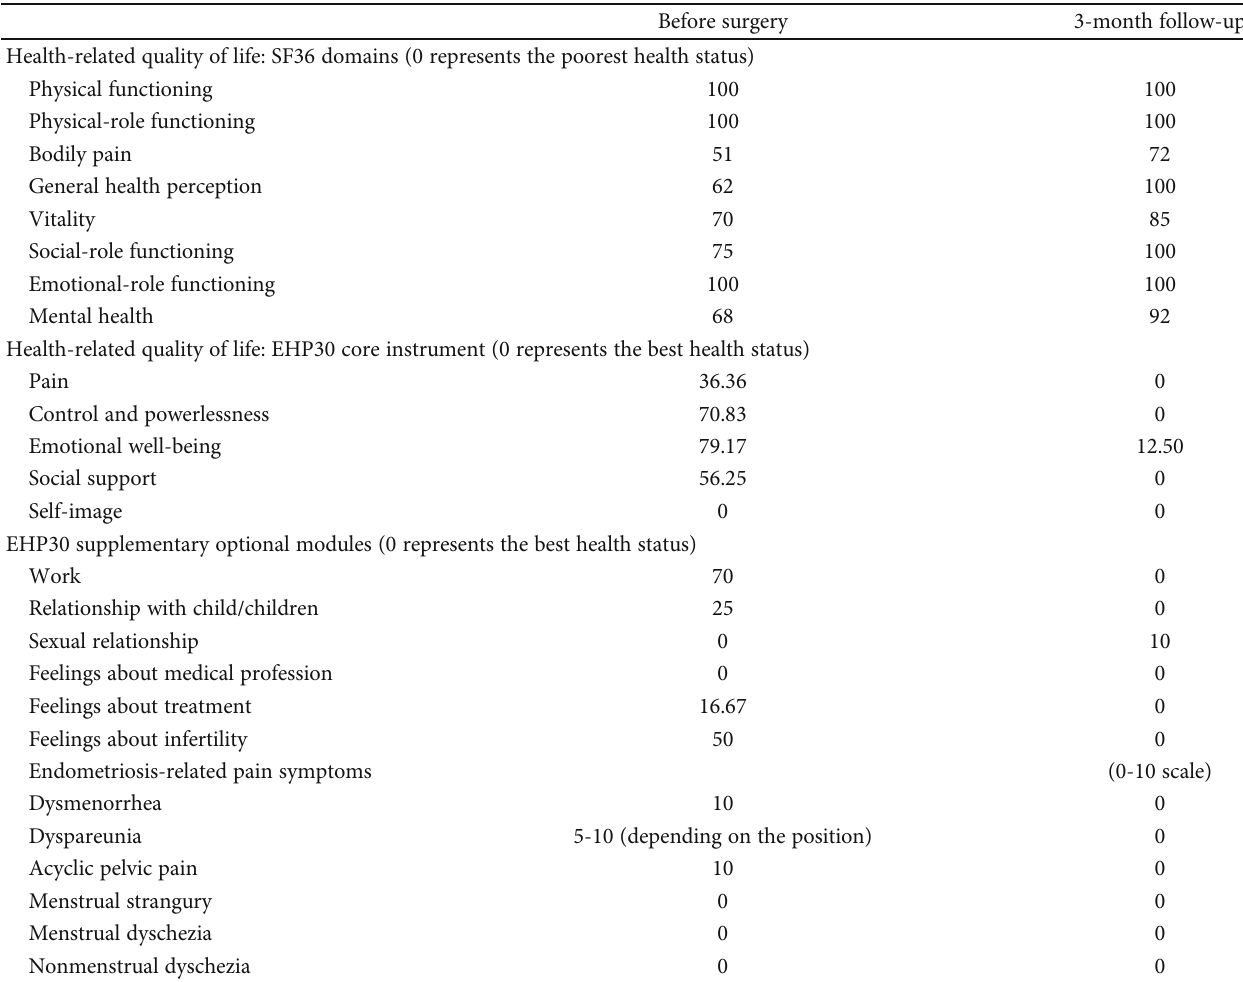
Table 1: Health-related quality of life and pelvic pain